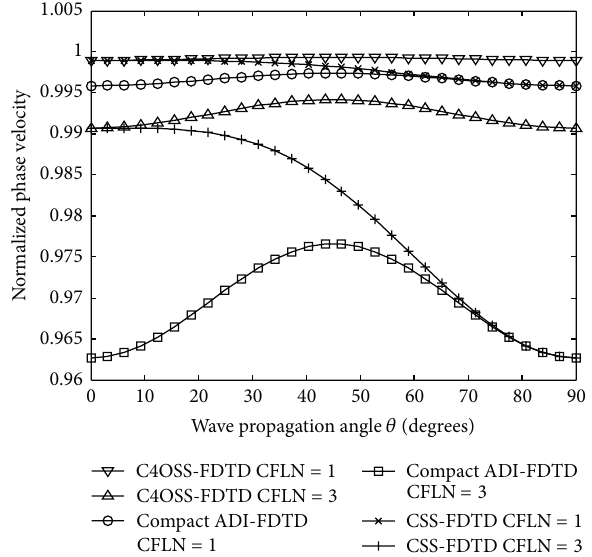
Figure 2: Normalized phase velocity of fourth-order compact methods ( 𝑁 𝜆 = 20 , CFLN = 1, 3).